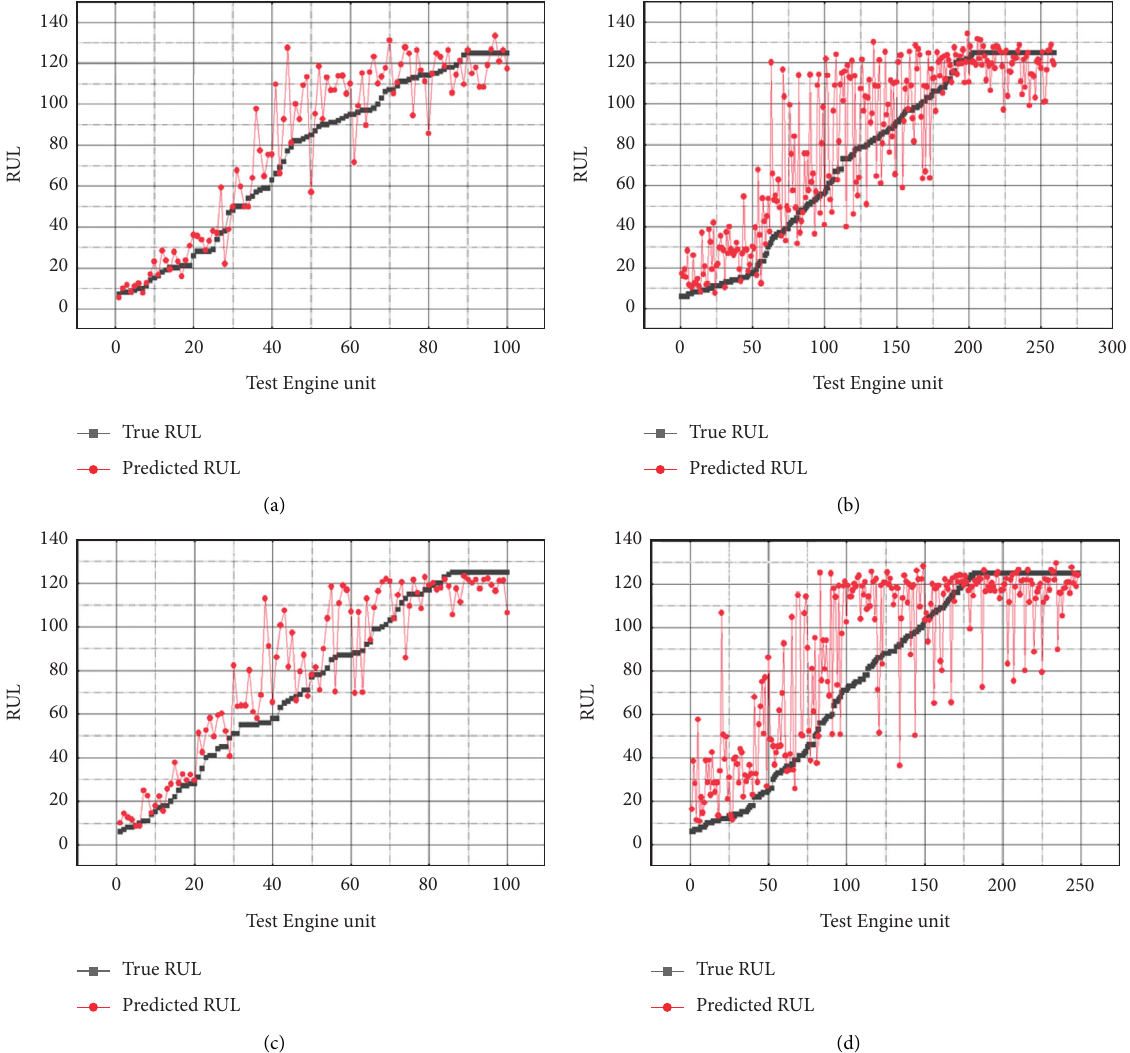
Figure 7: The results of RUL prediction after GAIN imputation when missing data rate is 0.1. (a) 100 test engine units on FD001. (b) 259 test